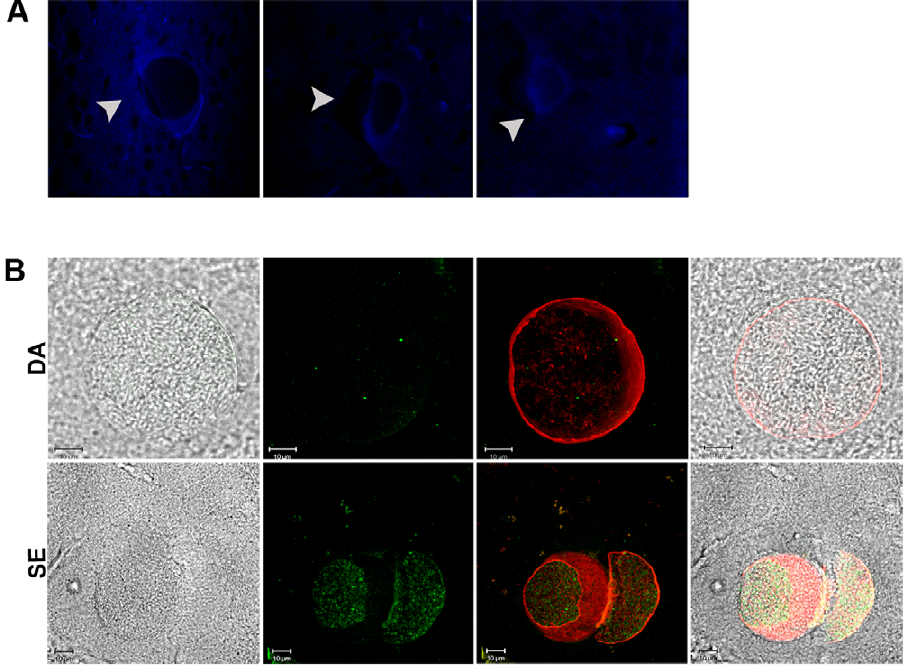
Figure 2. Specificity of dopamine stainingT.gondii tissue cysts. (A) Histochemical (glyoxylic acid) staining of dopamine in brain sections from chronically-infected mice detected by fluorescence. Glyoxylate reacts with dopamine to fluoresce blue-white [17]. Cells containing T. gondii cysts in brain tissue exhibited blue-white fluorescence. The tissue cysts stained darkly, similar to mouse cell nuclei, presumably due the high density of bradyzoites. (B) Brain tissue sections from chronically-infected mice were stained with indirect fluorescein staining as in Fig. 1 except the anti- dopamine primary antibody was incubated in the presence of 50 m g/ml dopamine (top) and 50 m g/ml serotonin (botto). From left to right: bright field, fluorescein only channel (green), fluorescein and lectin-TRITC (green and red channels, respectively), and both channels plus bright field. Serotonin did not compete for dopamine staining.